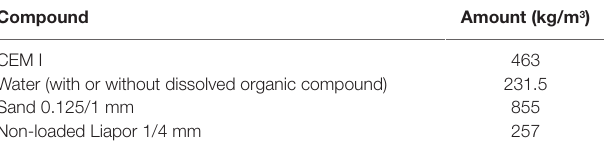
TaBle 1 | Mix design of the